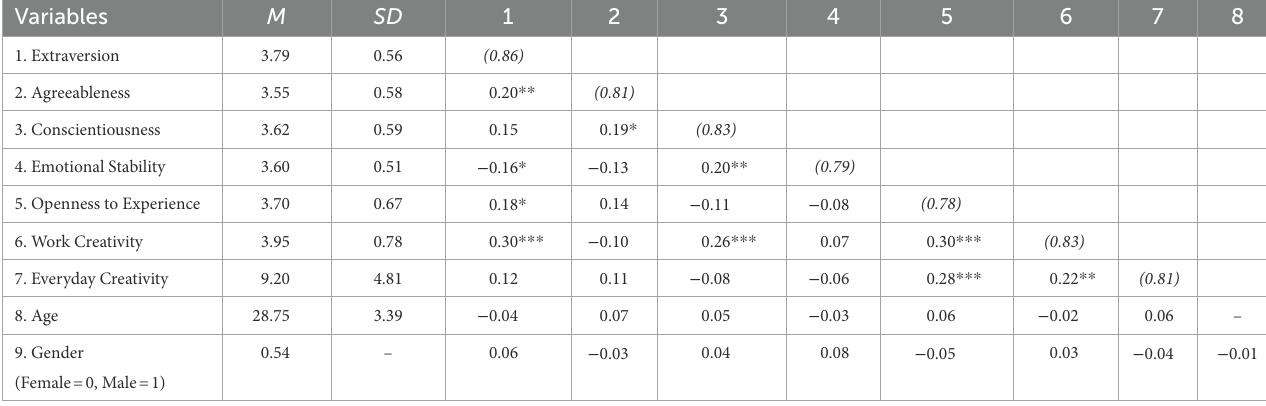
TABLE 1 Means, standard deviations, scale reliabilities, and inter-variable correlations. Variables